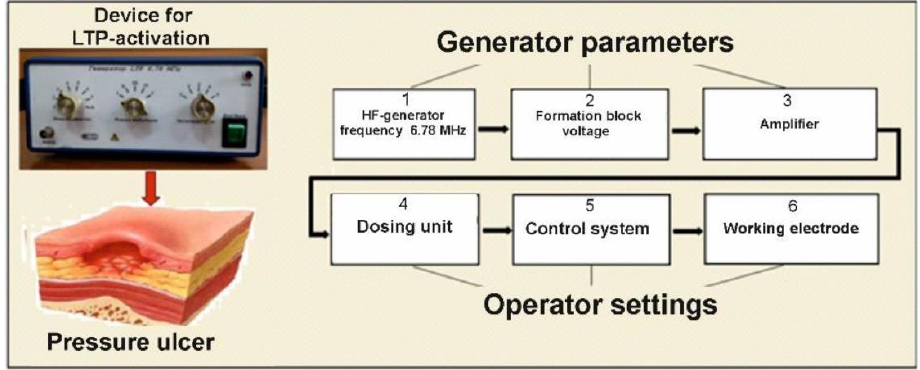
Figure 1. Functional block diagram of the device for activation of reparative processes.